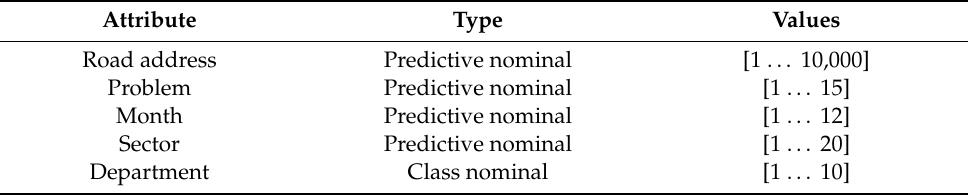
Figure 5. Data flow of the proposed system. Table 1. Papagos municipality section dataset description.